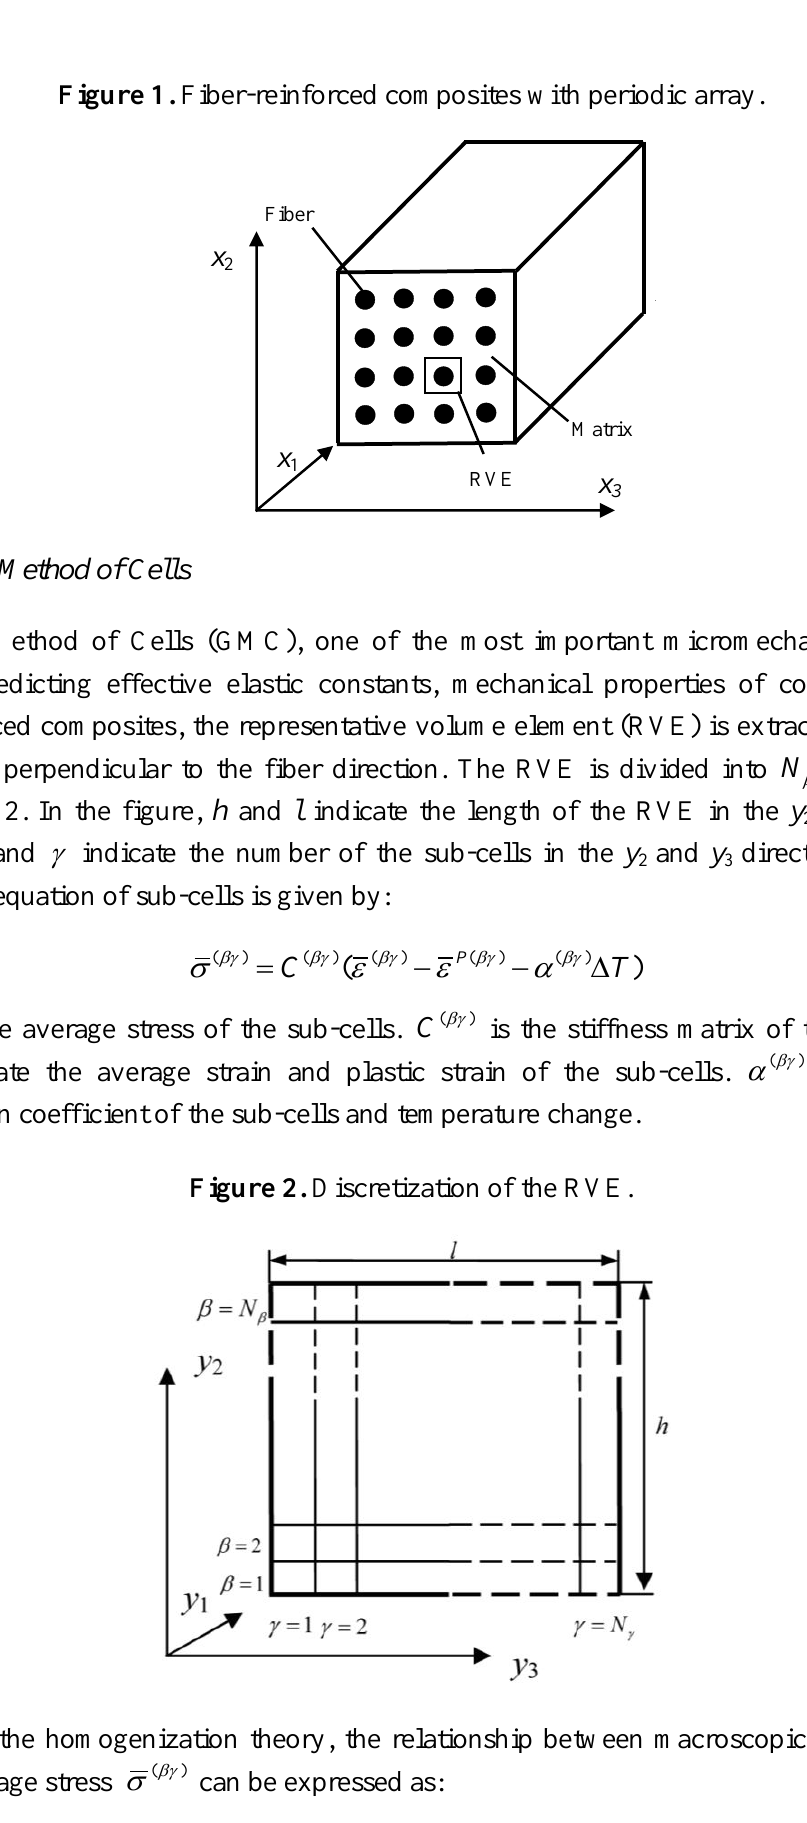
Figure 1. Fiber-reinforced composites with periodic array.